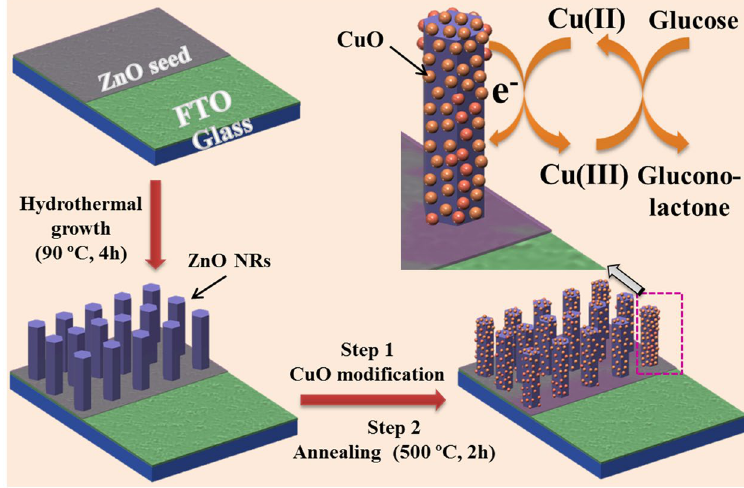
Figure 1. Schematic illustration. Non-enzymatic glucose sensor electrode fabrication and its application in glucose